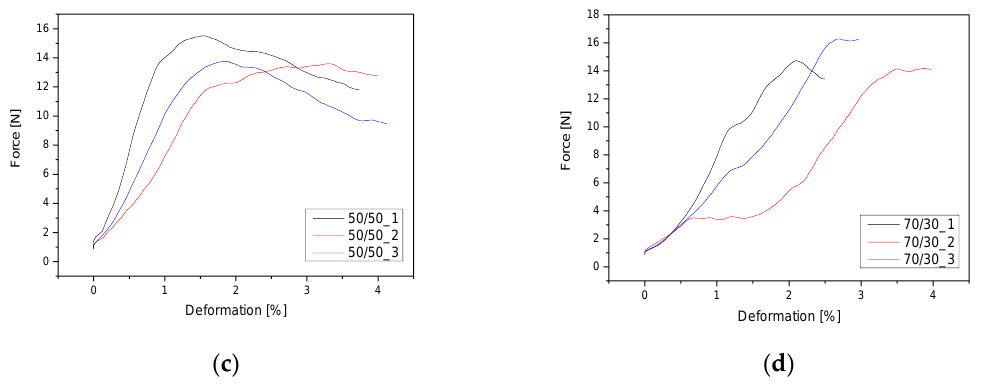
Figure 6. Force-Deformation curves: ( a ) pure BG; ( b ) pure β-TCP; ( c ) 50/50; and ( d ) 70/30. Experiments performed at Zwick Roell Universal Testing machine Z005 using Test Xpert II Software ( n = 3). Table 5. Failure load and compressive strength of the 3D printed Scaffolds ( n = 3).